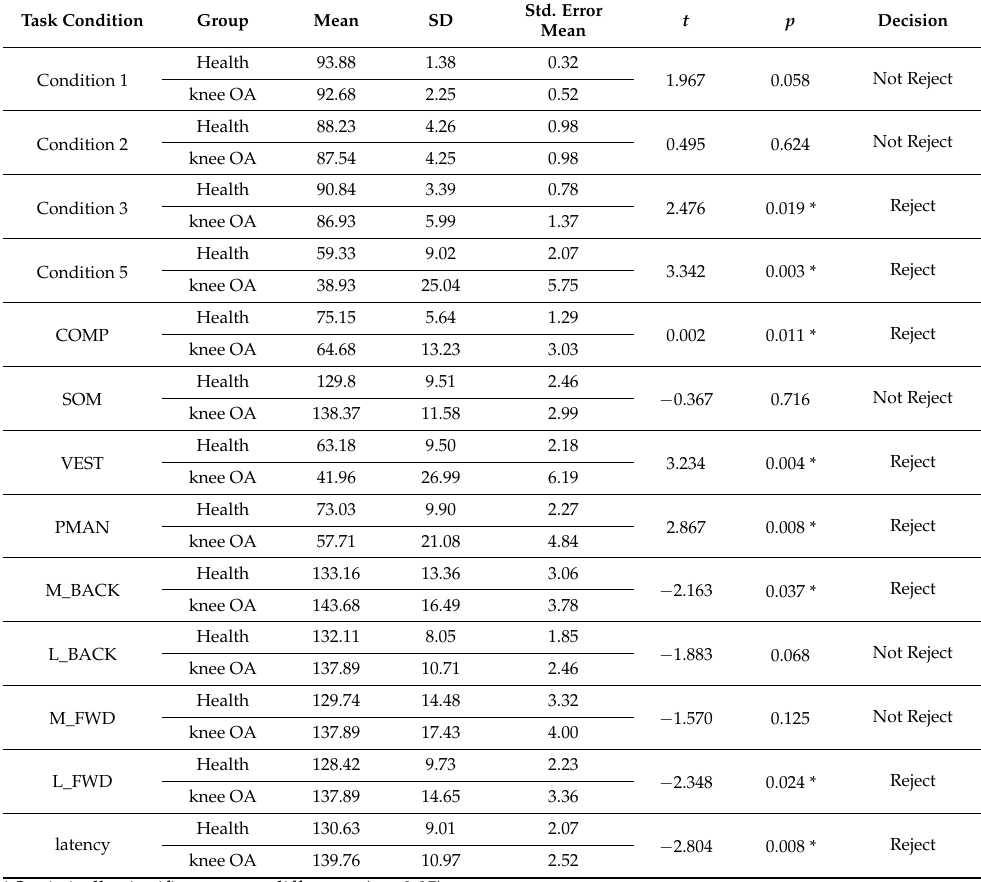
Table A1. Comparison between knee OA group and health knee group. (Null hypothesis: both knee OA and healthy knee groups will have the same scores from balance